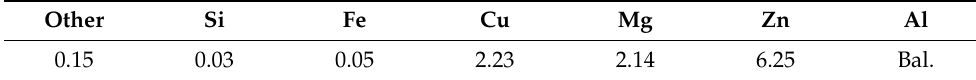
Table 1. Average chemical composition of AA7050-T6 (wt%).